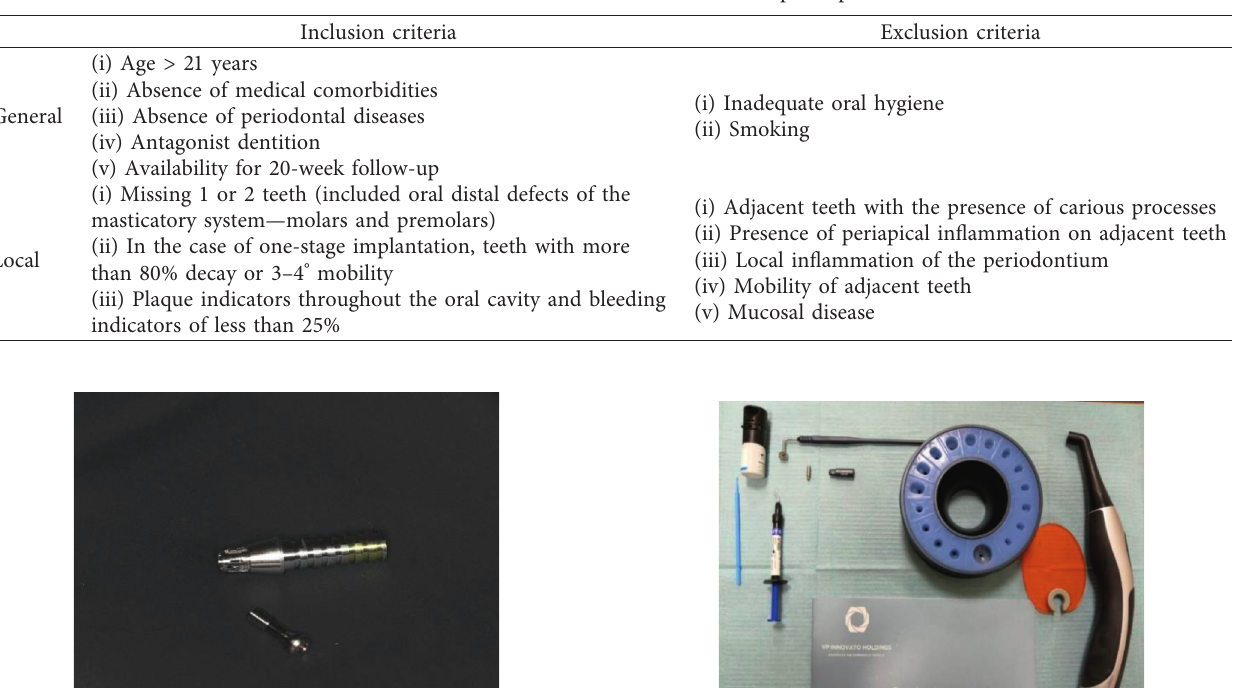
Table 2: Inclusion and exclusion criteria for the participants.